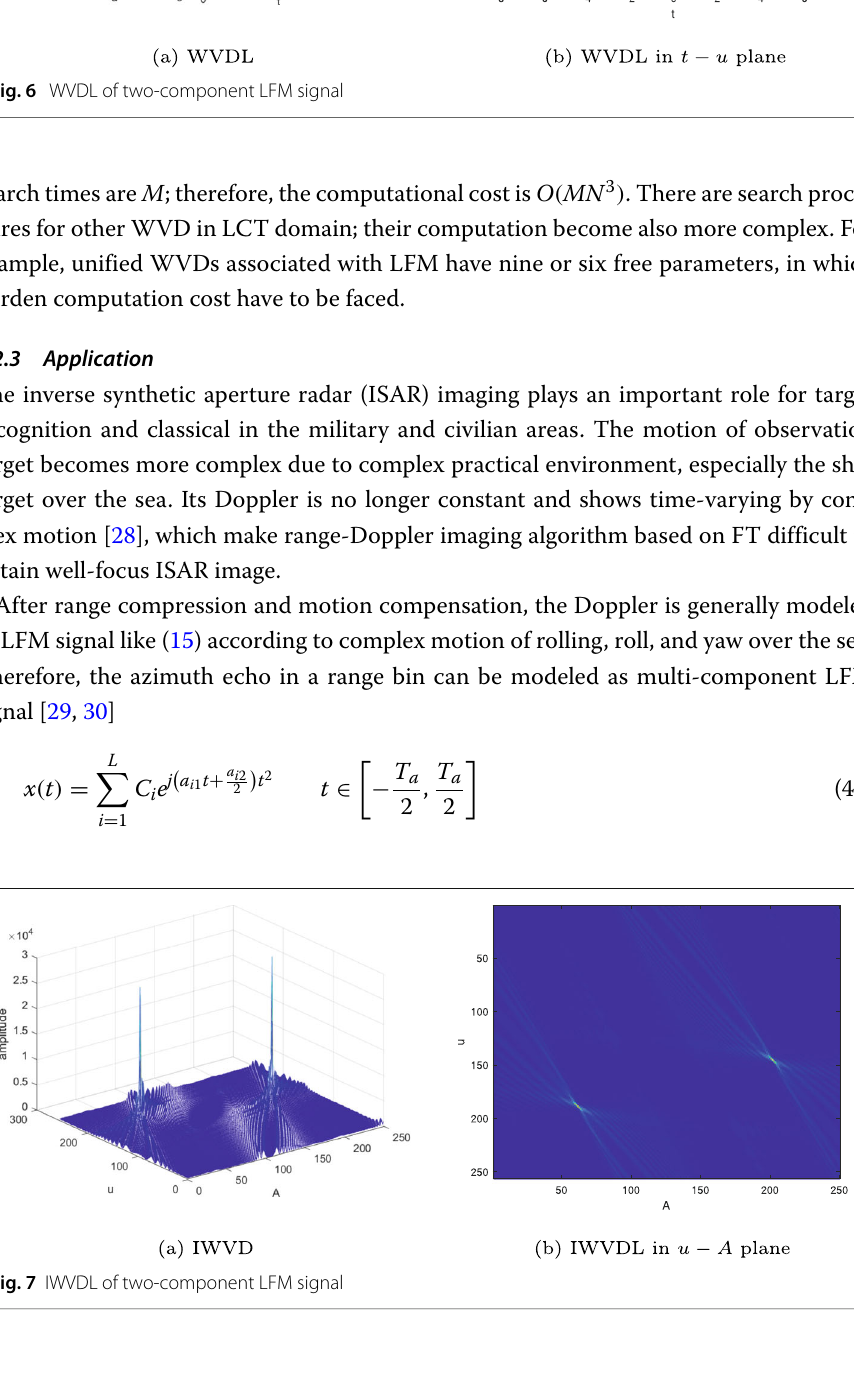
Fig. 6 WVDL of two-component LFM signal